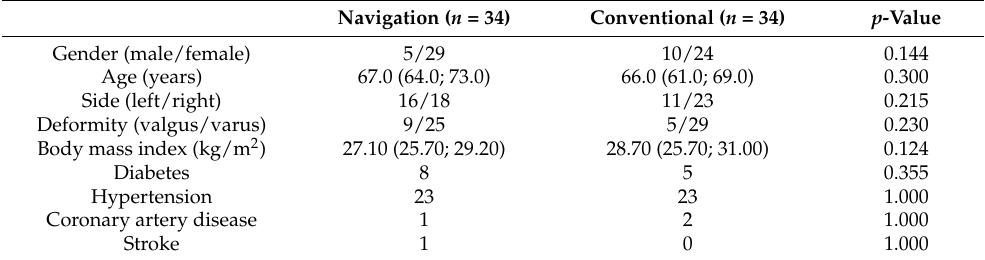
Table 1. The demographic profiles between the navigation and conventional